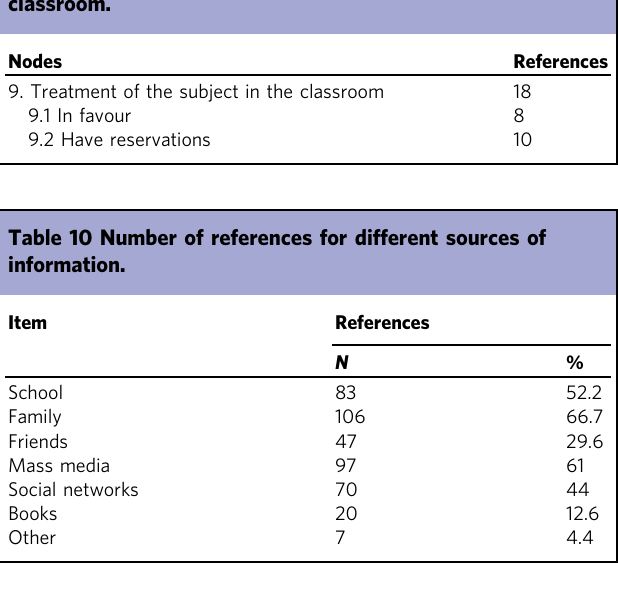
Table 9 Narratives: Treatment of the subject in the